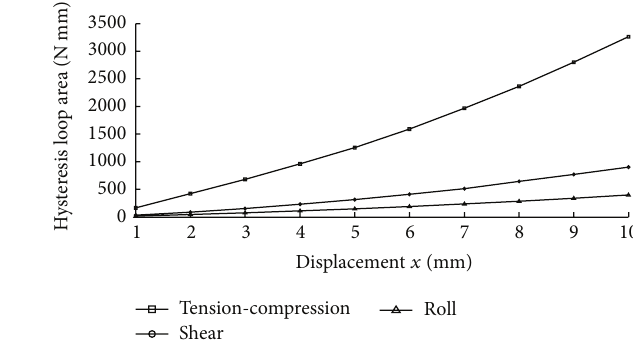
Figure 8: Measured hysteresis loops with different wire rope loop